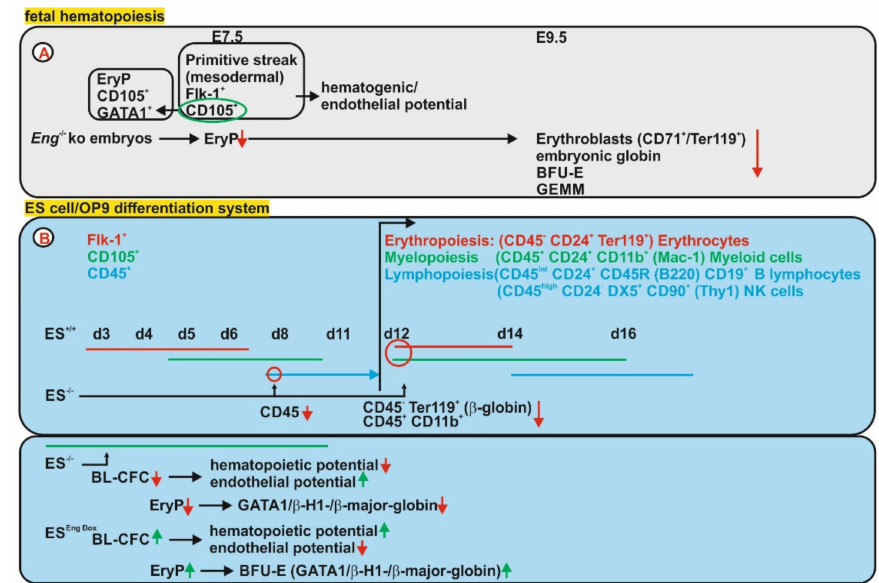
Figure 2. Endoglin expression and function in fetal hematopoietic cells. ( A ) Endoglin (Eng) expression is detected as early as embryonic day 7.5 (E7.5) in mesodermal cells (Flk-1 + ) and primitive erythroblasts (EryP, GATA1 + ) of the blood islands in wild-type mice. Endoglin expressing cells comprise all hematogenic and endothelial potential. In line, Eng deficiency (Eng − / − ) resulted in reduced EryP colonies and at E9.5 reduced erythroblasts (CD71 + / Ter119 + ) in the yolk sac (YS) and diminished numbers of BFU-E and GEMM progenitors. ( B ) (upper) Initially it was shown in the development of embryoid bodies, by culturing ES cells on OP9 feeder cells, that Endoglin is transiently expressed during the progression from Flk-1 + / CD45 + to the Flk-1 − / CD45 + stage. Using Endoglin deficient ES cells it gets evident that although Flk-1 mesodermal precursor di ff erentiation is normal, the CD45 + subset of hematopoietic cells is reduced at d9. In addition, the di ff erentiation of ES cells into erythroid (CD45 − / Ter119 + ) and myeloid (CD45 + / CD11b + ) was severely diminished along with a strongly reduced adult β -globin gene expression indicating impaired definitive erythropoiesis. (lower) Another study cell (BL-CFC) frequency and lowered its hematogenic potential, while increasing endothelial